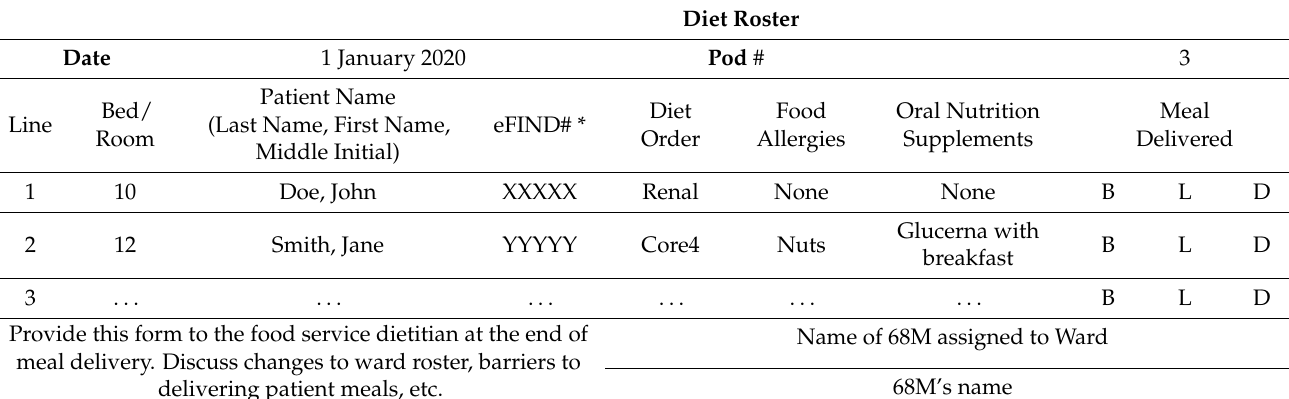
Table 2. An example of the ‘Diet Roster’ form, designed to quickly identify patients’ diet orders, food allergies and oral nutrition supplement requirements during meal delivery. Nutrition personnel would be expected to check, circle, or cross out the meals received by each patient once that meal had been administered on that